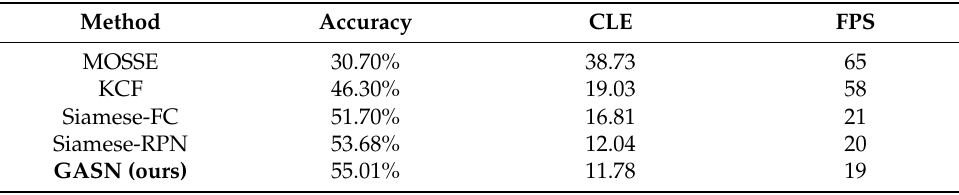
Table 5. Average tracking performance of another real Video-SAR data.